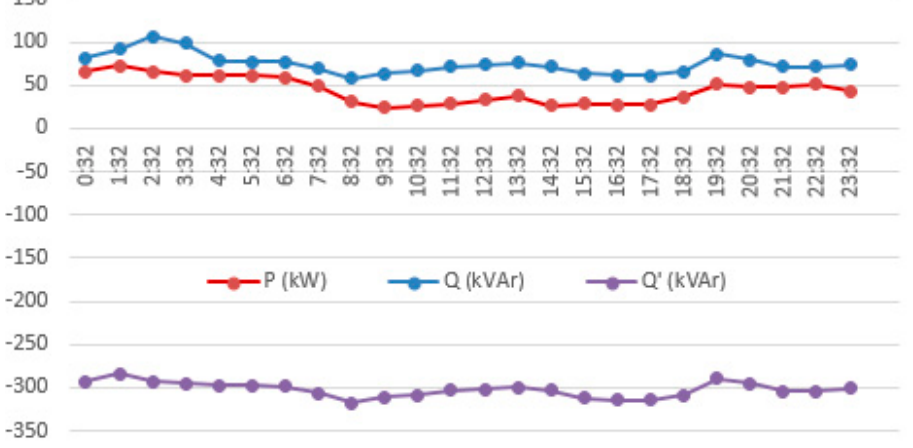
Figure 5. Active ( 𝑃 ) and reactive ( 𝑄′ ) powers delivered by the transformer during holidays, as well as the reactive powers ( 𝑄 ) supplied without capacitor banks. (Negative sign indicates capacitive reactive powers).